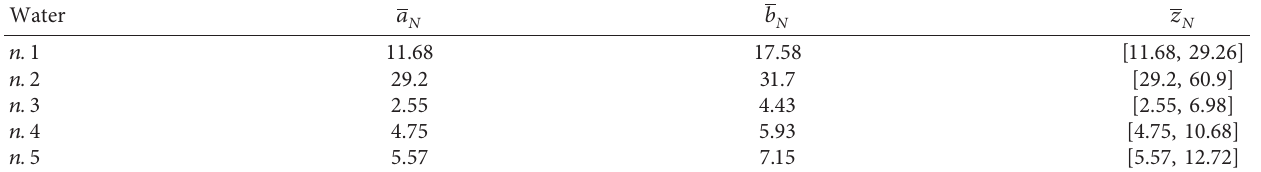
Table 2: Neutrosophic means of five different types of